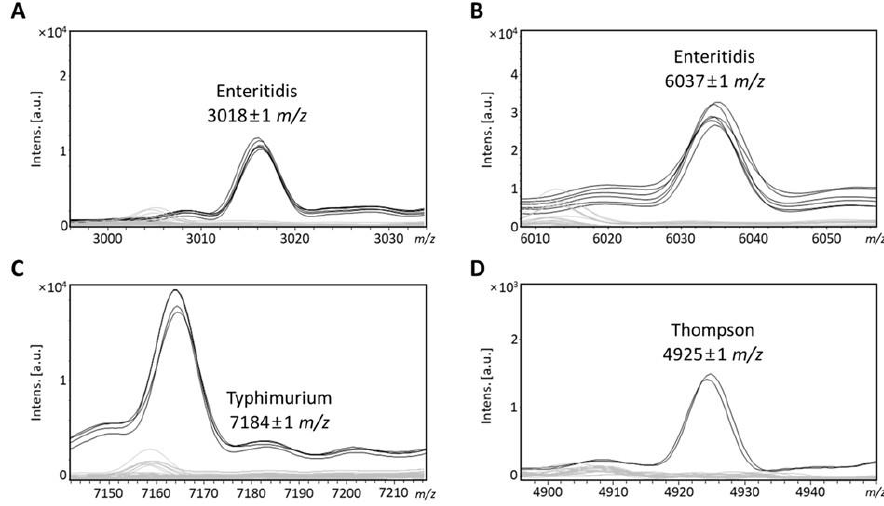
Figure 4. Specific peaks for three serovars. ( A ) Mass peak at 3018 ± 1 m/z presents in serovar Enteritidis reference strains, ( B ) mass peak at 6037 ± 1 m/z presents in serovar Enteritidis strains, ( C ) mass peak at 7184 ± 1 m/z presents in serovar Typhimurium strains, and ( D ) mass peak at 4925 ± 1 m/z presents in serovar Thompson. Table 5. Identification of isolates by antisera agglutination and specific